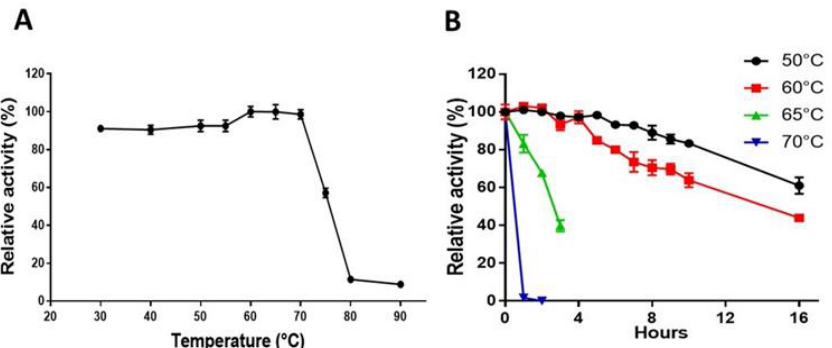
Figure 6. AmCel9 catalytic activity at different temperatures ( A ) and thermo-resistance in the range of 50 ◦ C to 70 ◦ C ( B of 50 °C to 70 °C ( B ).